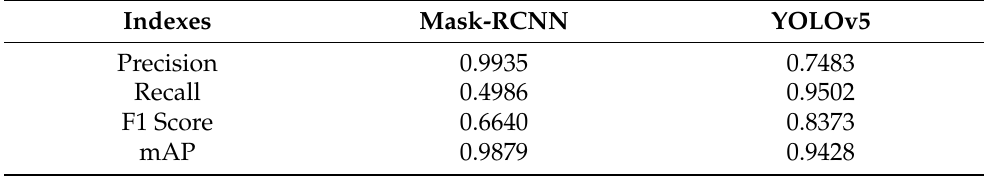
Table 1. Evaluation indexes of generated model files by Mask-RCNN and YOLOv5